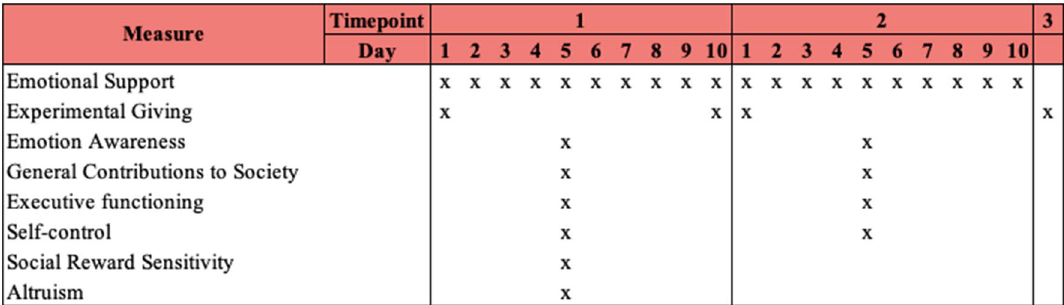
Figure 2. Timeline of administered measures at each